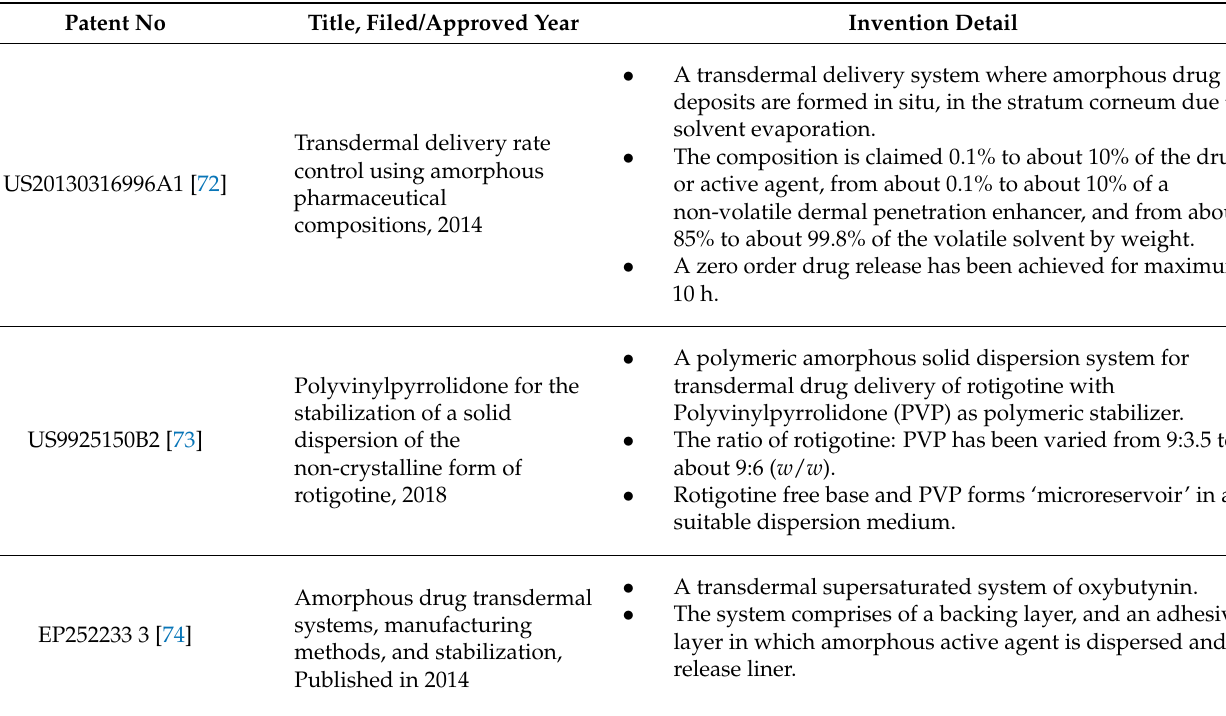
Table 3. Patents on transdermal amorphous drug loaded